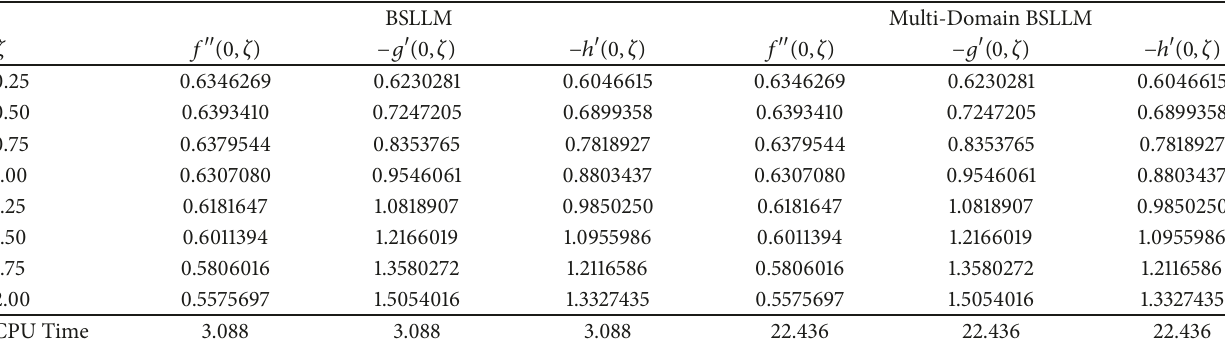
Table 5: Comparison of the MD-BSLLM and the BSLLM solution for 𝑓 󸀠󸀠 (0,𝜁) , −𝑔 󸀠 (0,𝜁) , and −ℎ 󸀠 (0,𝜁) : 𝑛 = 𝑤 = 1/2 , 𝑃𝑟 = 0.7 , and 𝑆𝑐 = 0.6 .